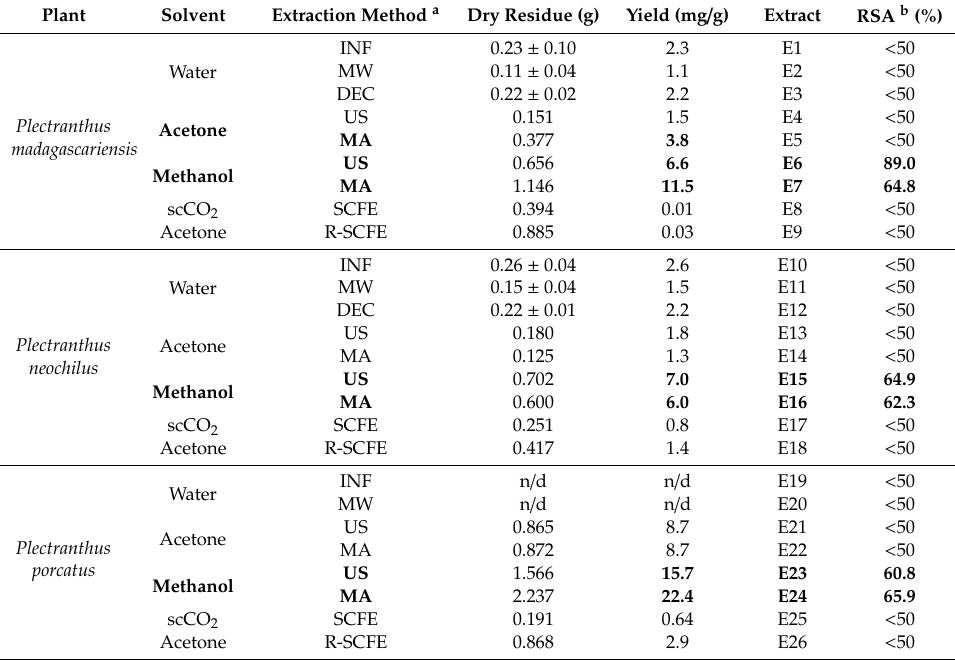
Table 1. Plectranthus spp. extraction yields according to solvent and extraction method, and radical scavenging activity (RSA) of the extracts (100 µ g / mL) in the DPPH